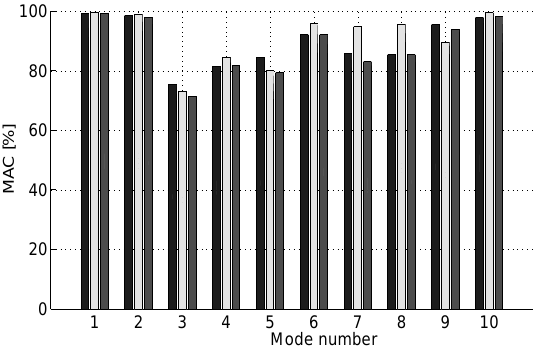
Fig. 9. Mode correlation of the updated model: R&A dark gray, R&AV light gray, R&MAC medium gray.